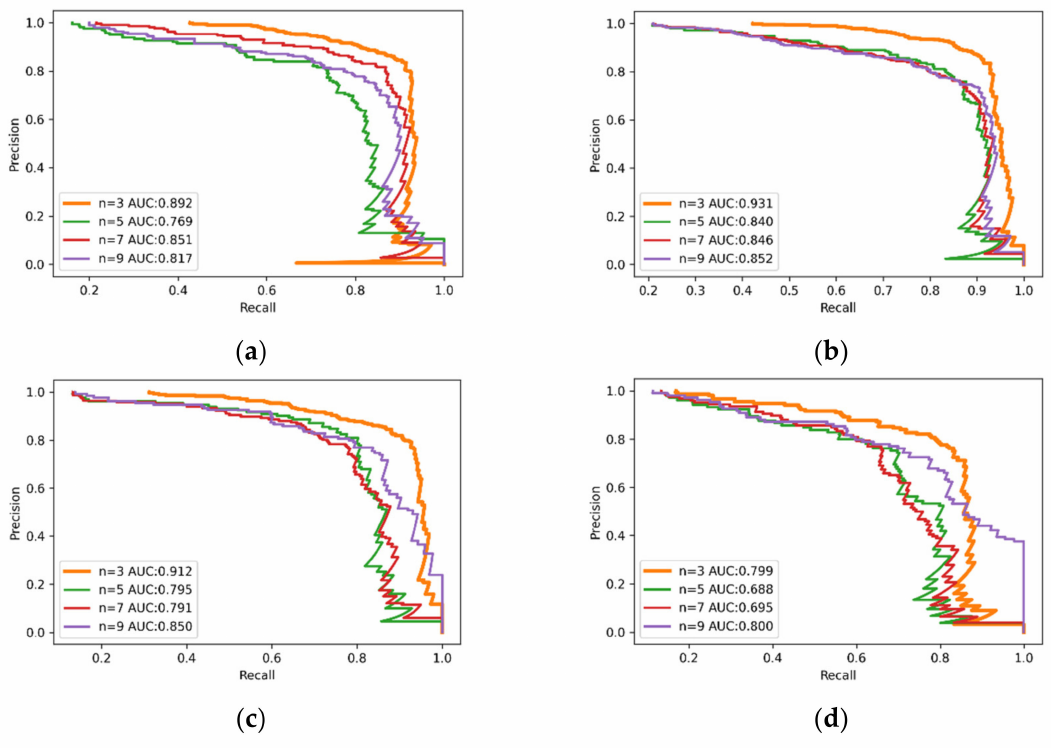
Figure 8. PR curves of the model when varying the convolutional scale n and the fully connected layer m : ( a ) m = 8; ( b ) m = 16; ( c ) m = 32; ( d ) m =